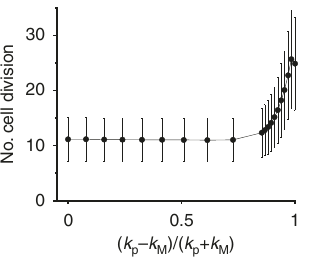
Fig. 5 The average number of cell divisions a protocell undergoes along its line of descent as a function of the degree of functional asymmetry, ( k P − k M )/( k P + k M ). Error bars indicate s.d. The initial fi tness of protocells, measured by the expected fraction of replicators within a protocell, was kept constant for the different values of ( k P − k M )/( k P + k M ) (for details, see Methods section under ‘ The measurement of the number of cell divisions ’ ). Parameters: m = 0.01, d = 0.0632. V =